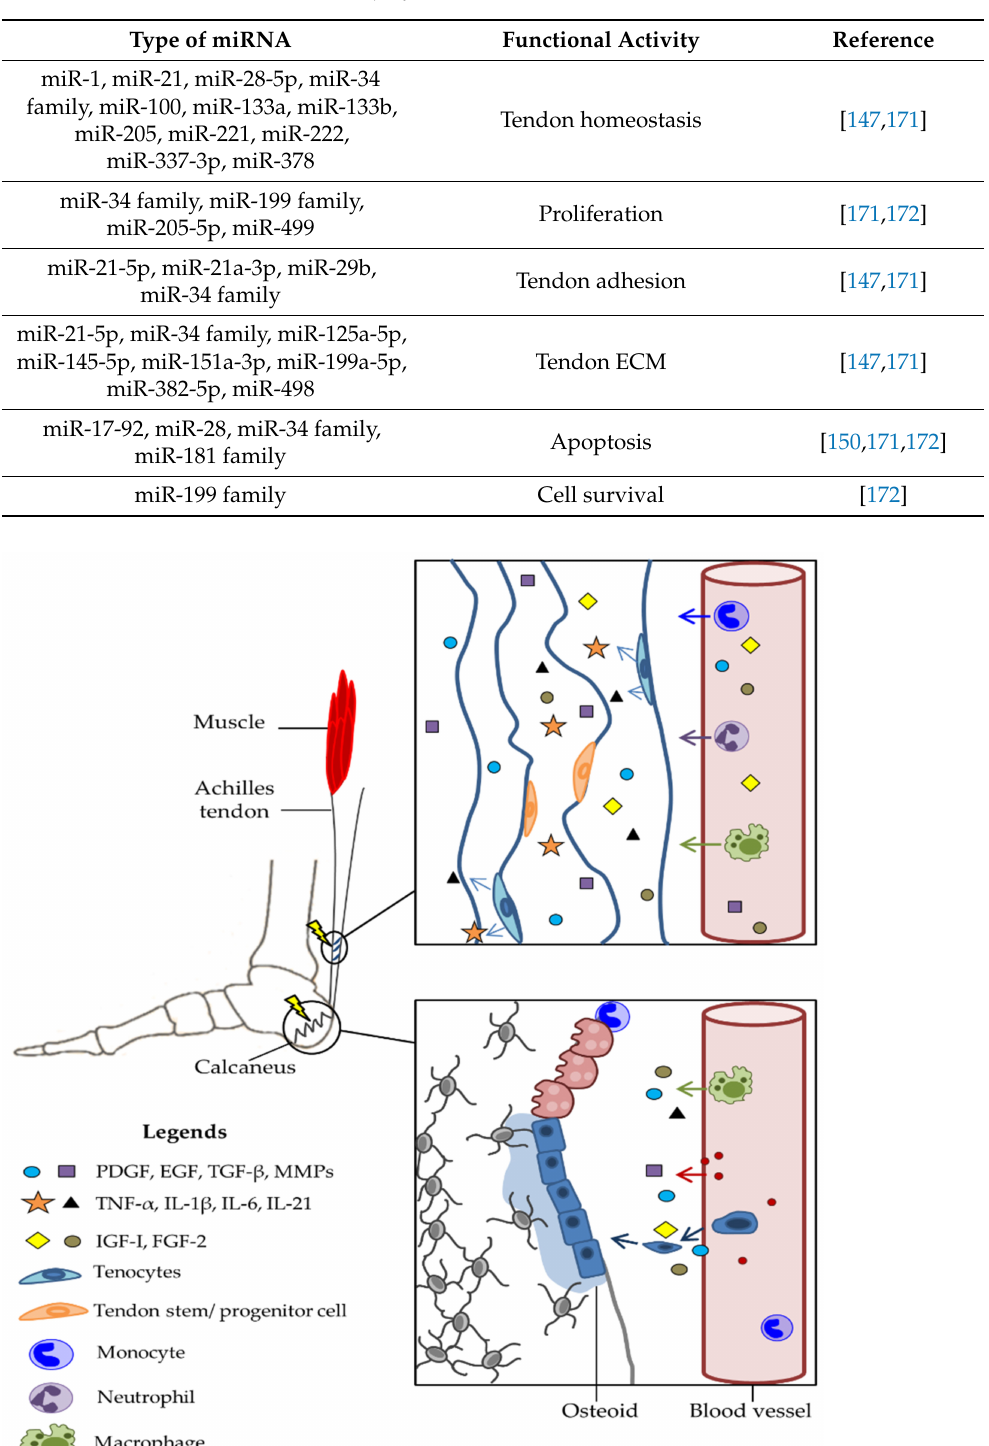
Table 3. Roles of miRNA in tendon injury.